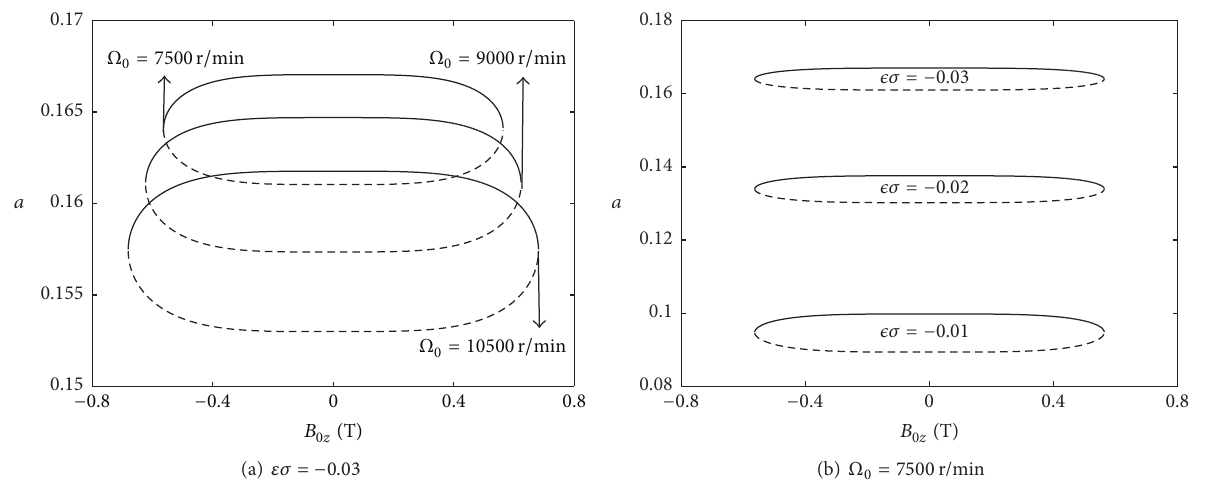
Figure 4: The characteristic curves of amplitude-magnetic induction